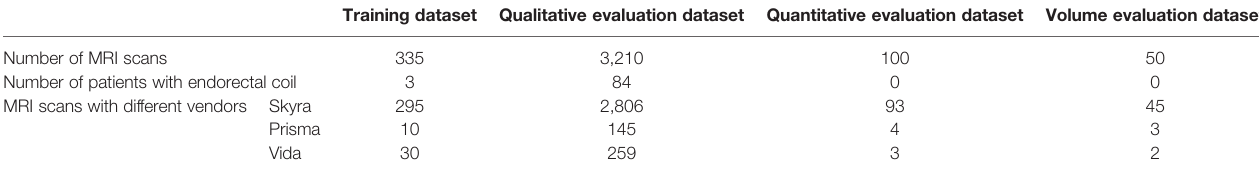
TABLE 2 | Data characteristics in the training, qualitative, and quantitative